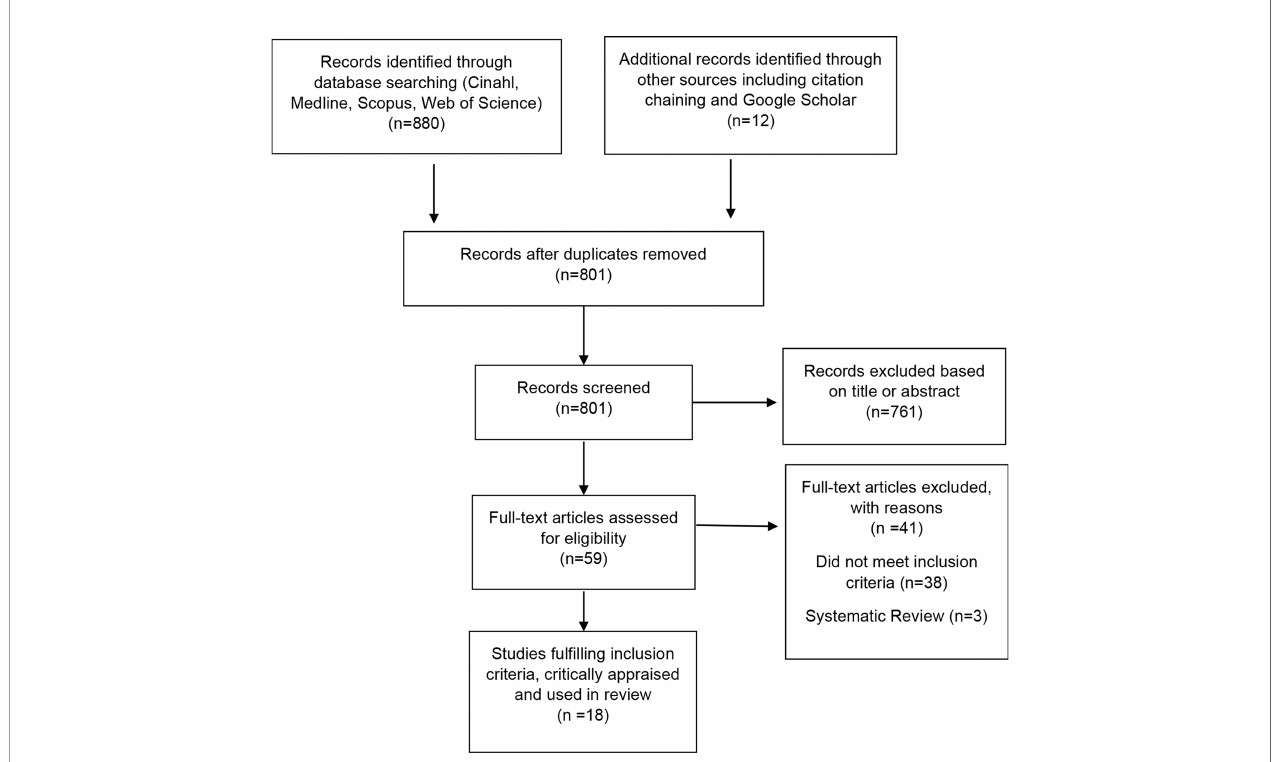
FIGURE 1 | Flow diagram showing results of searches for systematic